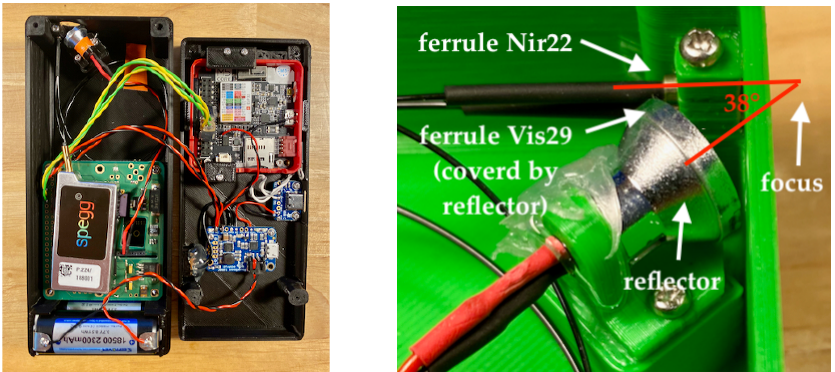
Figure 1. The OpenVNT hardware. Left : Inside view of the instrument. Right : Probe